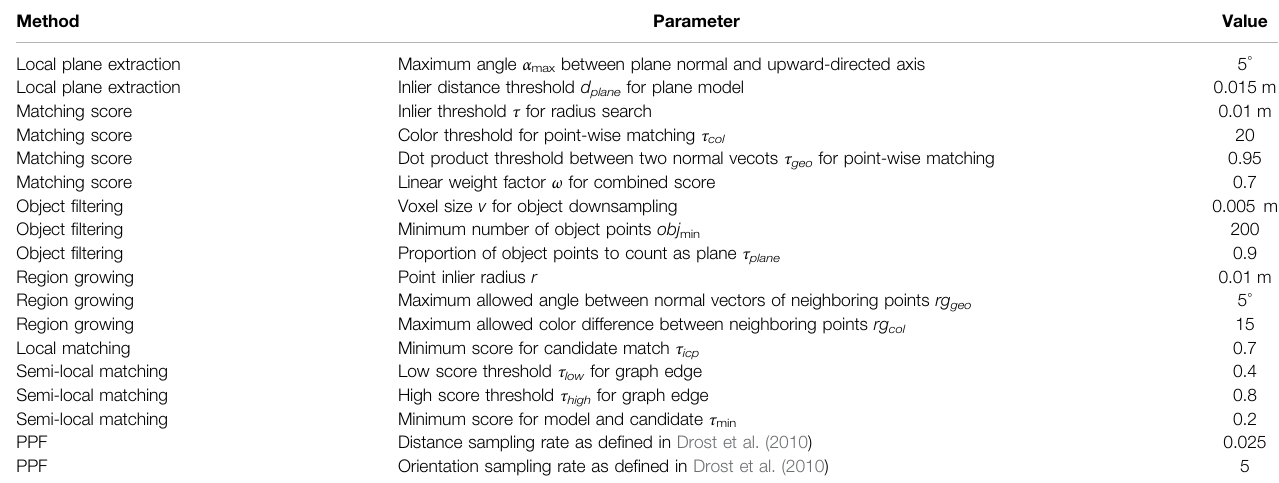
TABLE 2 | Parameters used for